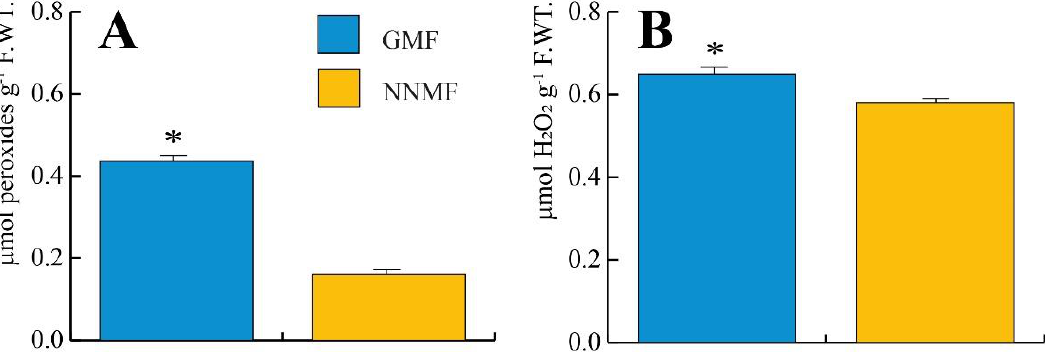
Figure 11. Expression of the main genes coding for enzymes involved in ROS metabolism. SOD , superoxide dismutase; CAT , catalase; APX , ascorbate peroxidase; PRX , peroxidase; GR , glutathione reductase and GPX , glutathione peroxidase. Data are expressed as fold changes with respect to the housekeeping gene actin. In order to emphasize the visualization of data, fold change values below zero were plotted as − 1/value, in order to obtain negative fold change values (indicating downregulation). Metric bars indicate standard deviation, asterisk indicates significant ( p < 0.05) differences between the GMF and NNMF.